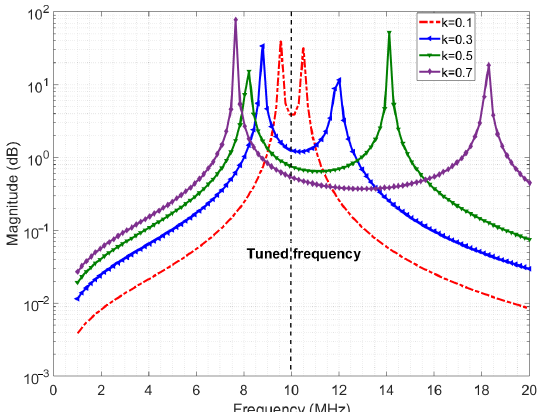
Figure 4. Ideal channel